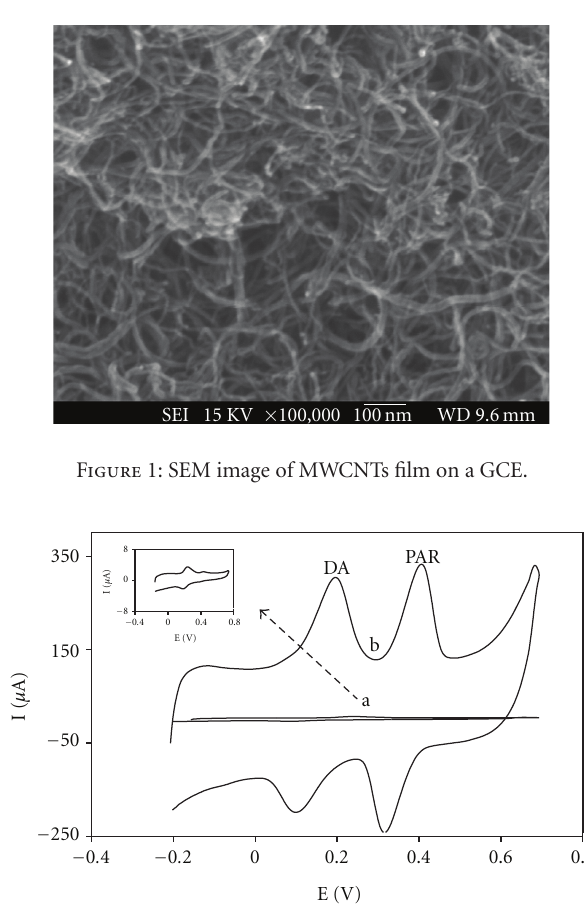
Figure 2: Cyclic voltammograms of 70 μ M DA and 50 μ M PAR at MWCNTs/GCE in 0.1 M phosphate bu ff er solution (pH 7) at scan rate of 100 mVs − 1 .